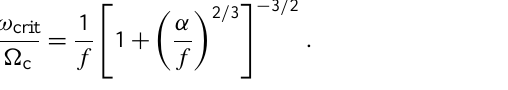
Fig. 2. Effective plasma frequency ω eff p as a function of wave am- plitude α , for various temperatures. Solid line: cold plasma case ( f = 1); dashed line: f = 2; dotted line: f =